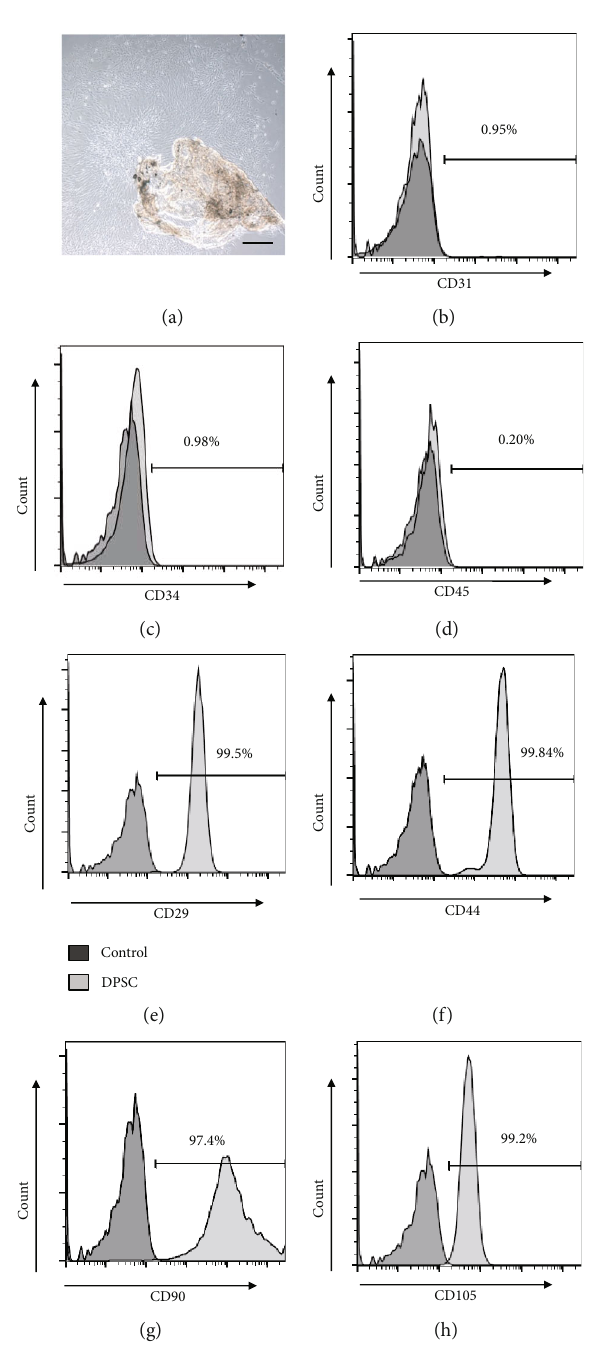
Figure 1: Primary human DPSC identi fi cation. (a) Primary DPSCs were isolated from dental pulp tissue. (b – h) Isolated DPSCs were CD29, CD44, CD90, and CD105 positive and were CD31, CD34, and CD45 negative in fl ow cytometry analyses. All the experiments were repeated at least three times independently. Scale bar = 100 μ